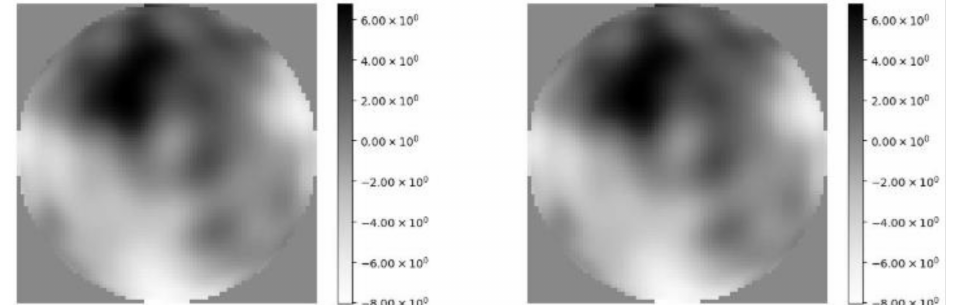
Figure 4. Comparison of a sample of the test set with r 0 of 8 cm for the CNN model. On the left, the original reconstructed turbulence phase and, on the right, the one reconstructed by the CNN. With a naked eye both phases’ profiles are very similar.